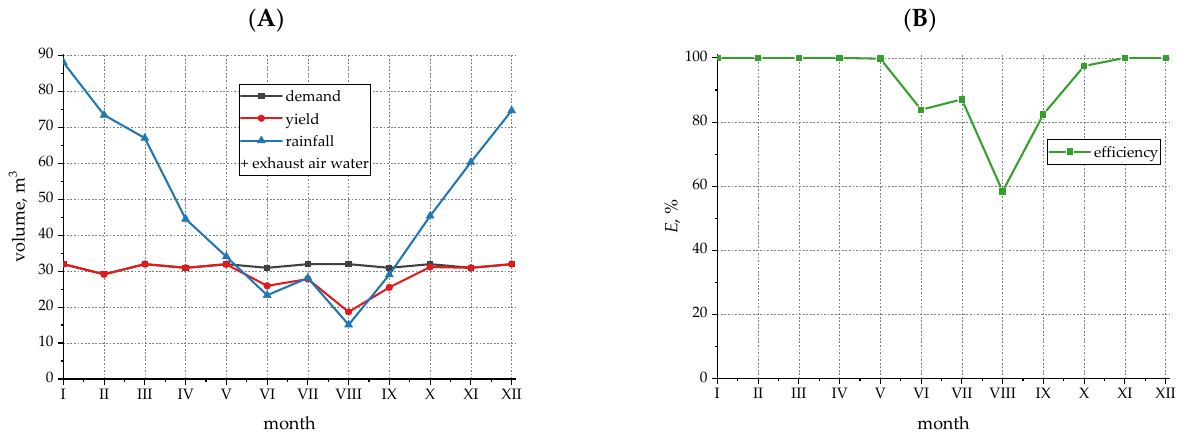
Figure 7. Mean monthly characteristics of combined water recovery system. For tank capacity S = 12 m 3 . ( A ) Water demand, rainfall volume, and yield. ( B ) Monthly variation of system efficiency.